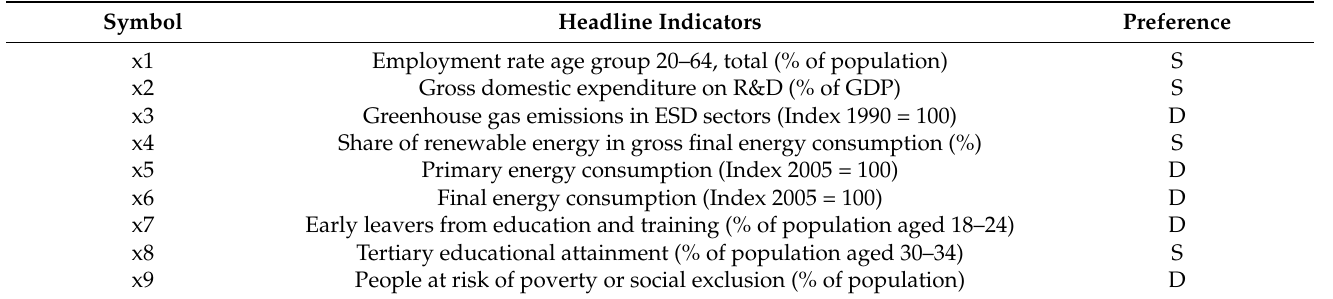
Table 2. The variables used in the assessment of the Europe 2020. Symbol Headline Indicators